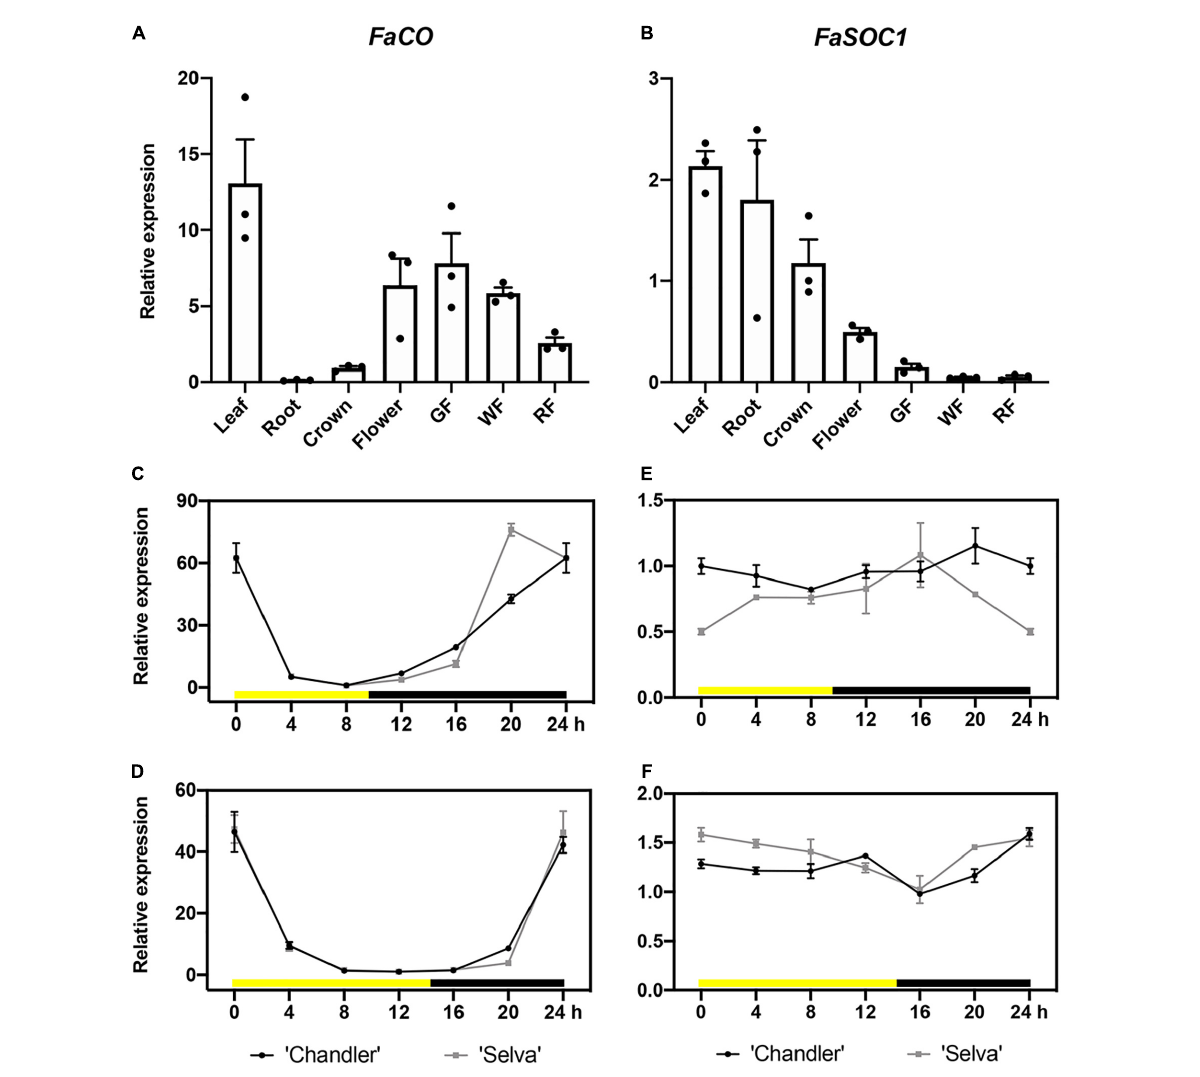
FIGURE2 Spatial and diurnal expression of FaCO and FaSOC1 by RT-qPCR. Relative expression levels of FaCO (A) and FaSOC1 (B) in different tissues or organs. mRNA diurnal rhythms of FaCO under SD (C) and LD (D) . mRNA diurnal rhythms of FaSOC1 under SD (E) and LD (F) . The first sample was taken at dawn: 0 h Zeitgeber time (ZT). Relative gene expression levels were normalized to the expression of FaGAPDH and crown tissue (A,B) , 8 h (C,D) , or 16 h (E,F) were used as reference samples. Data are means ± SEM of three biological